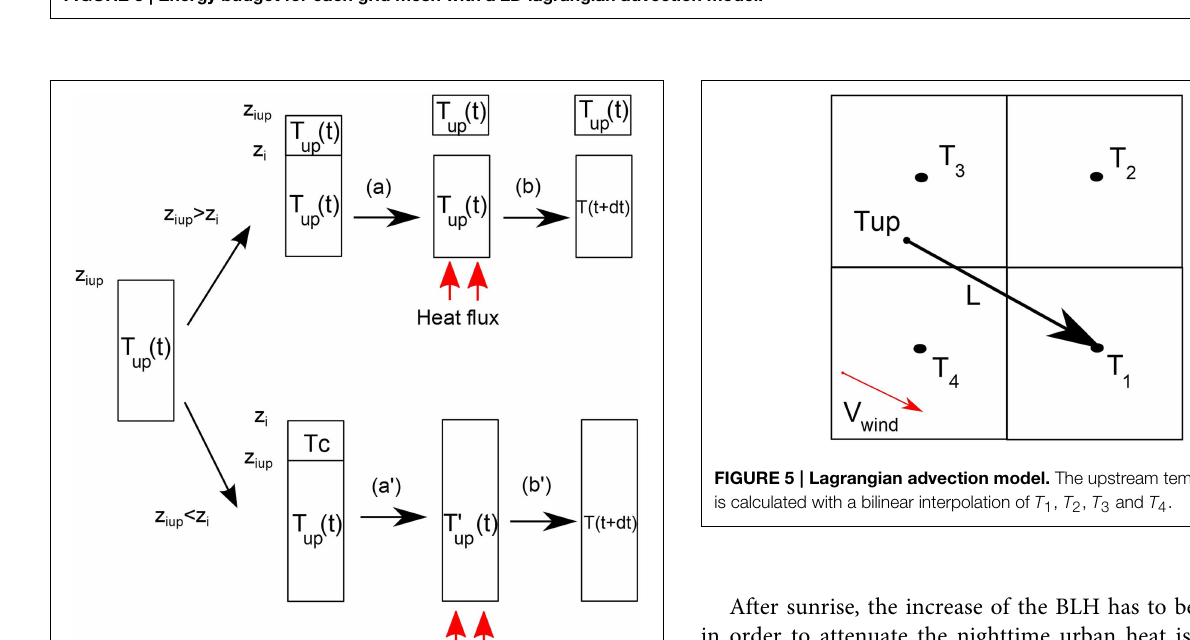
FIGURE 3 | Energy budget for each grid mesh with a 2D lagrangian advection model.